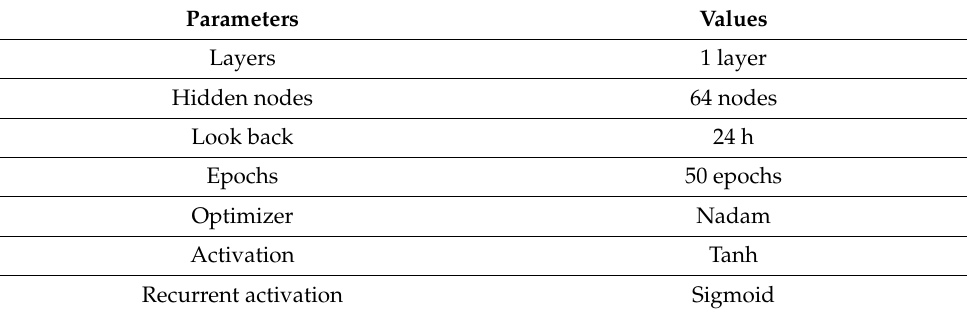
Table 6. Best parameters setting for the